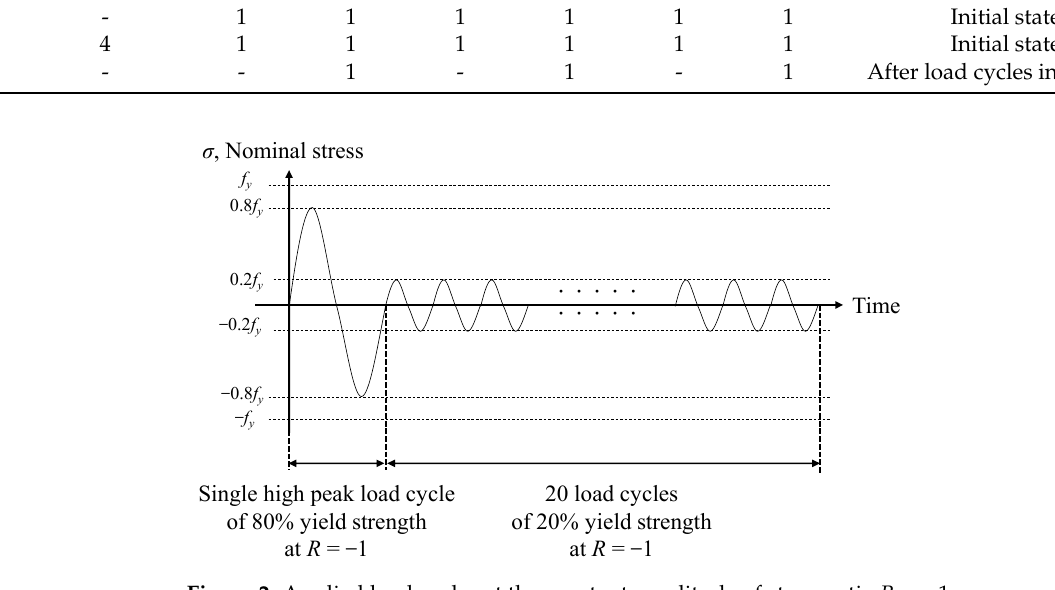
Figure 2. Applied load cycles at the constant amplitude of stress ratio R = − 1. Table 2. Test matrix of residual stress measurements.